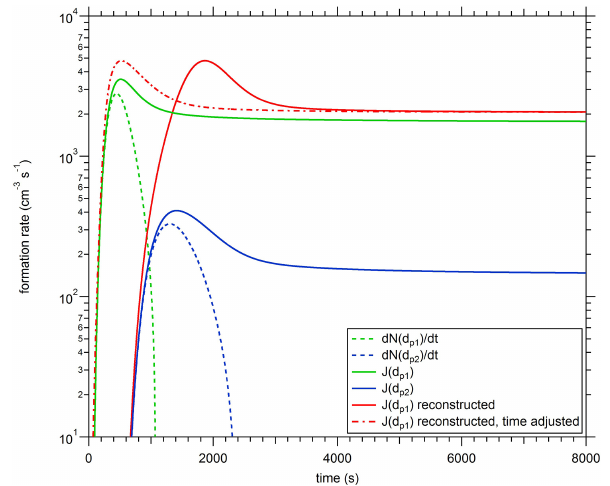
Figure 6. Particle formation rates J (cm − 3 s − 1 , solid lines) and change in particle concentration d N/ d t (cm − 3 s − 1 , dashed lines) shown for two different sizes, d p 1 = 1.4nm (green lines) and d p 2 = 2.9nm (blue lines). The data are from a kinetic model cal- culation. The reconstructed J(d p 1 ) is shown by the solid red line. Through use of a time correction, the reconstructed J(d p 1 ) are shifted to earlier times (dash-dotted red